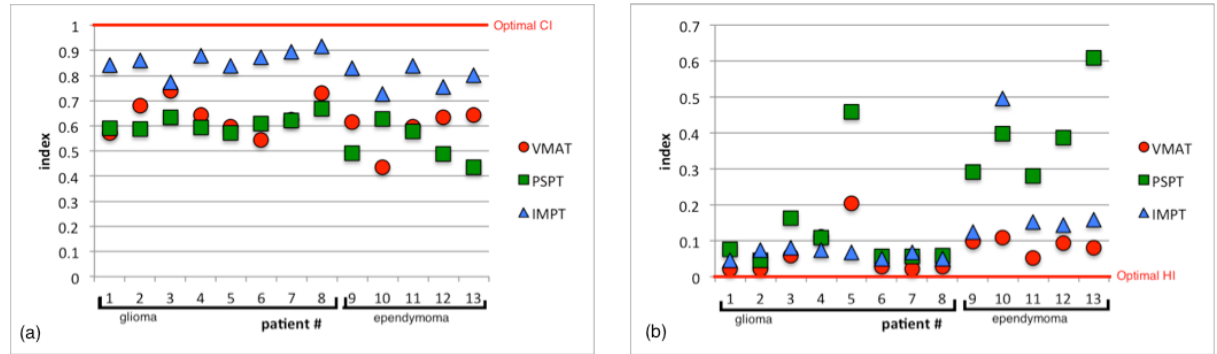
Figure 4. ( a ) The conformity of the dose to the PTV represented by the conformity index (CI) for VMAT, PSPT, and IMPT plans. ( b ) The homogeneity of the dose to the PTV represented by the homogeneity index (HI) for VMAT, PSPT, and IMPT